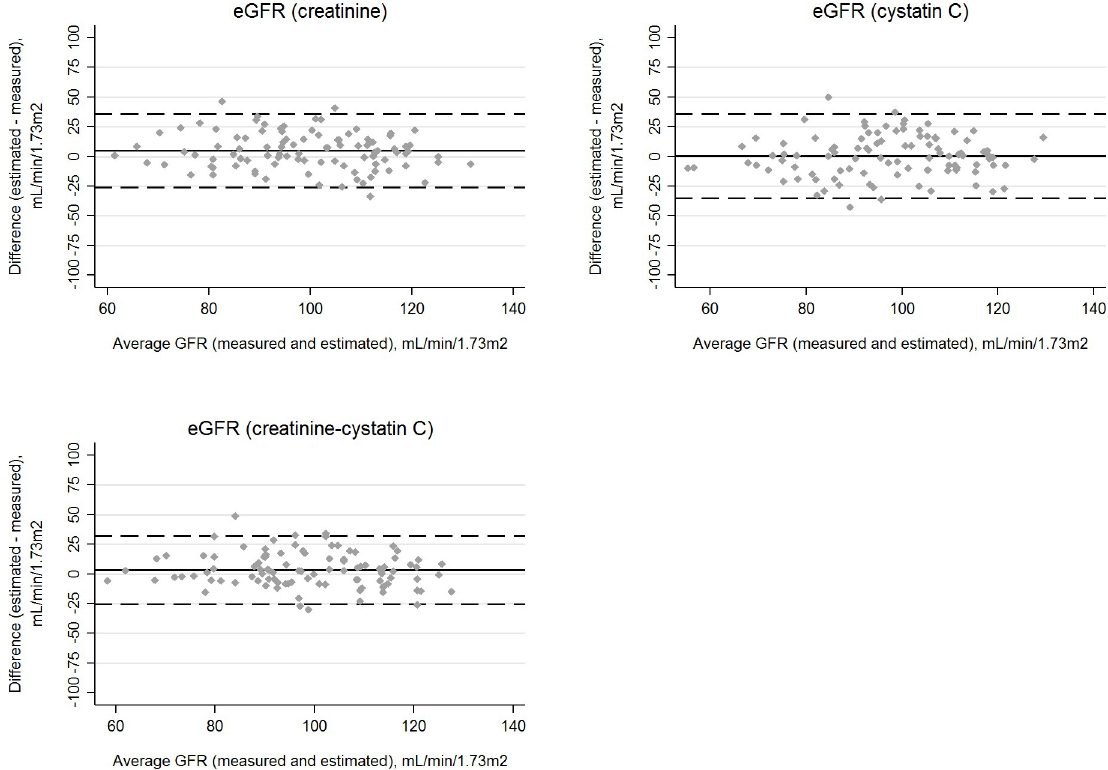
Fig 2. Bland-Altman plots for estimated and measured glomerular filtration rate (GFR) in HIV-negative participants using the CKD-EPI equations for serum creatinine (A), cystatin C (B), or both biomarkers (C). The average GFR (measured and estimated) is shown on the X axes. Bias, defined as the difference between estimated and measured GFR, is displayed on the Y axes. The average biases are represented by the horizontal solid lines and the horizontal dashed lines represent 2 standard deviations above and below the averages.